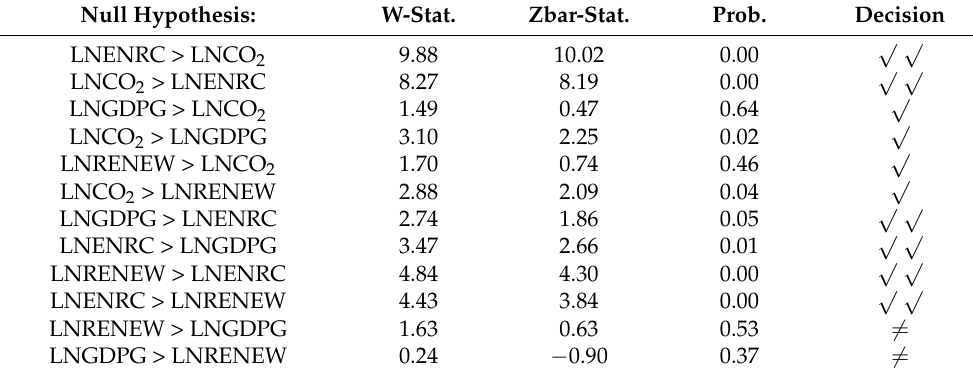
Table 9. Dumitrescu Hurlin Panel Causality